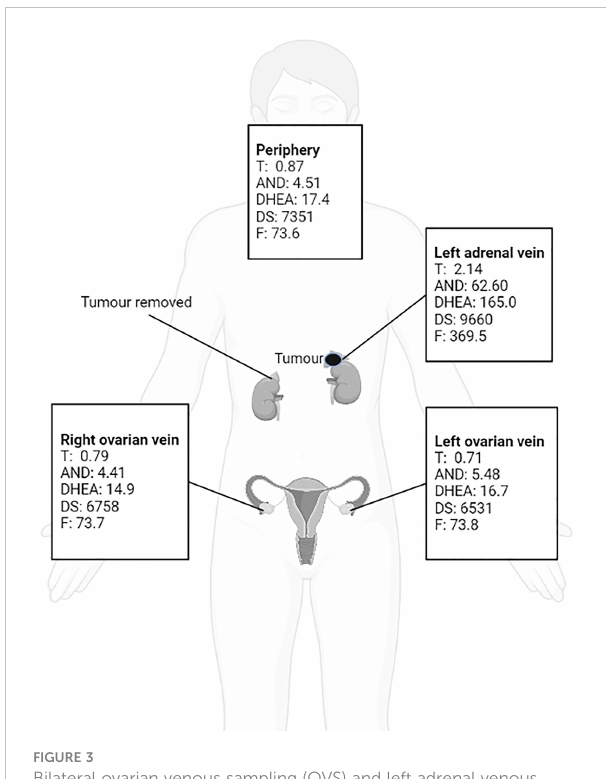
FIGURE 3 Bilateral ovarian venous sampling (OVS) and left adrenal venous sampling